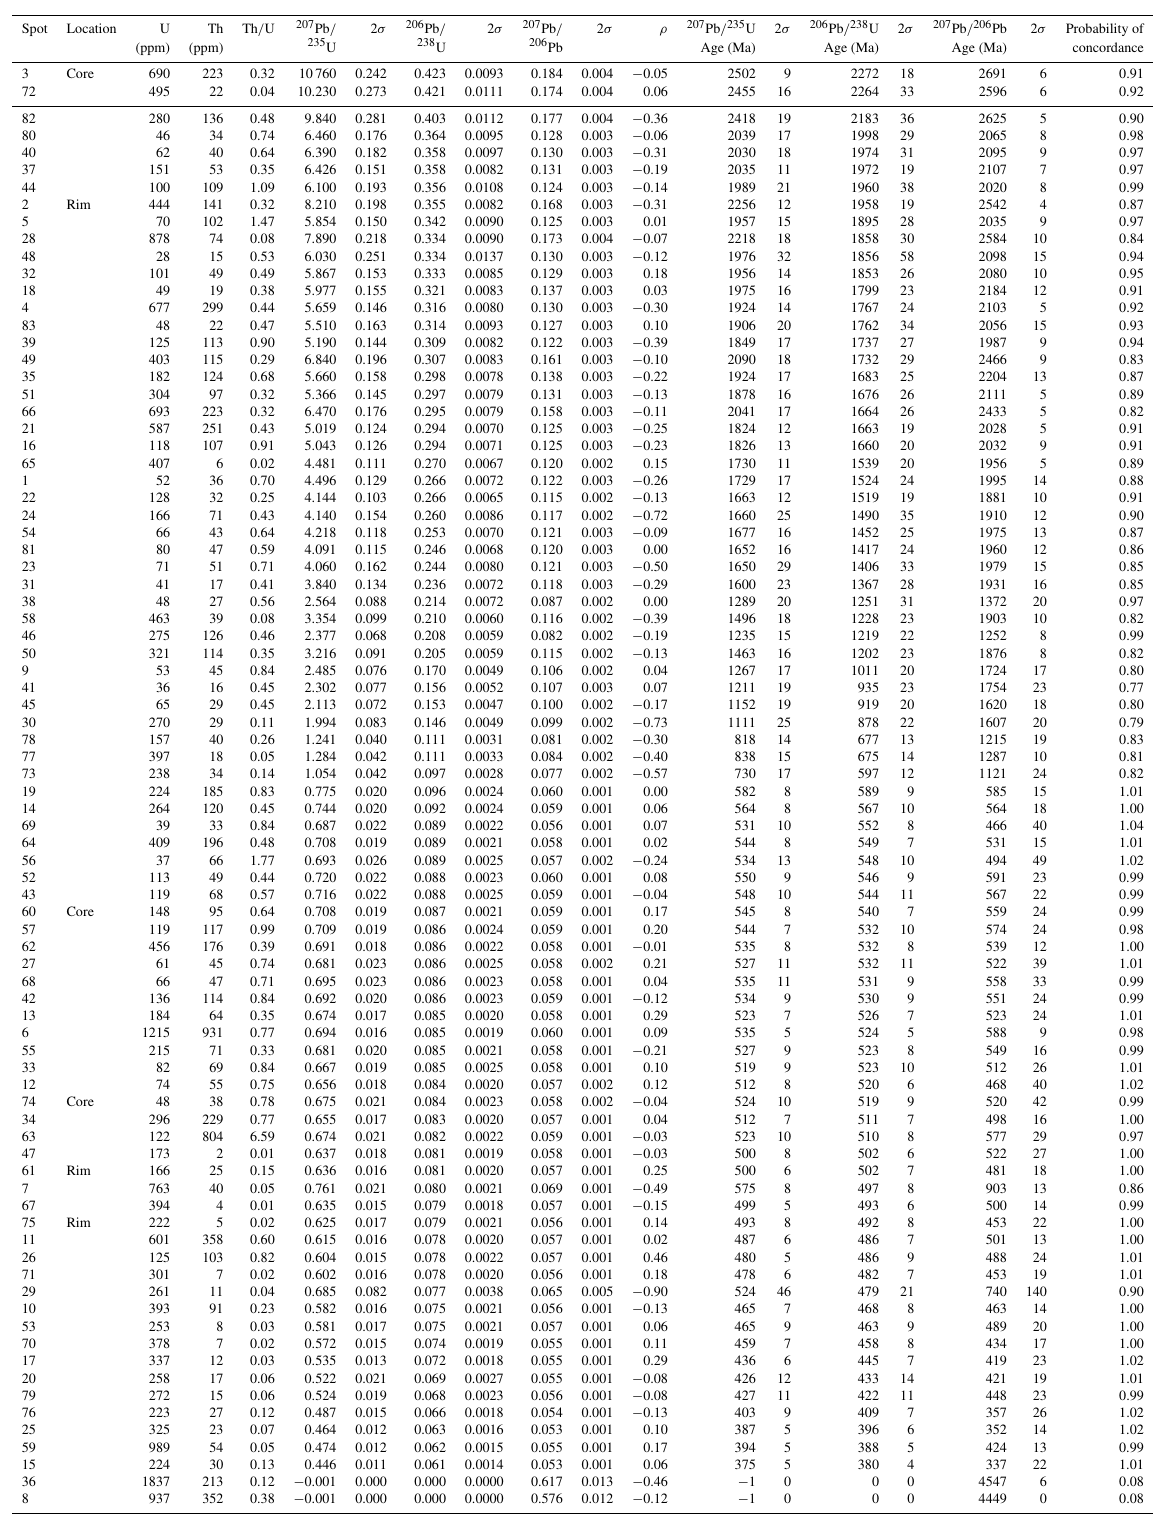
Table 3. U–Th_Pb zircon sorted by age. Spot